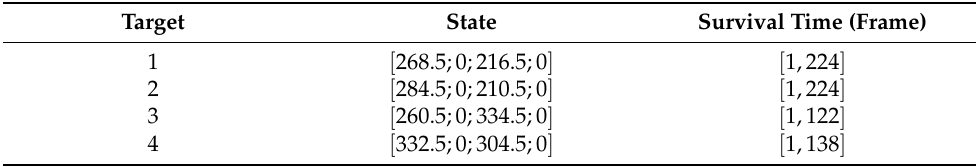
( d ) Figure 8. Initial set for multiple ellipses method. (a) – (d) are four different models of shapes. To demonstrate the effect of the measurement partition method on tracking perfor- mance, three methods are compared in this study: the amplitude-aided method (AP), the distance-based method (DP) and grid-based DBSCAN (GBDBSCAN) algorithm for which